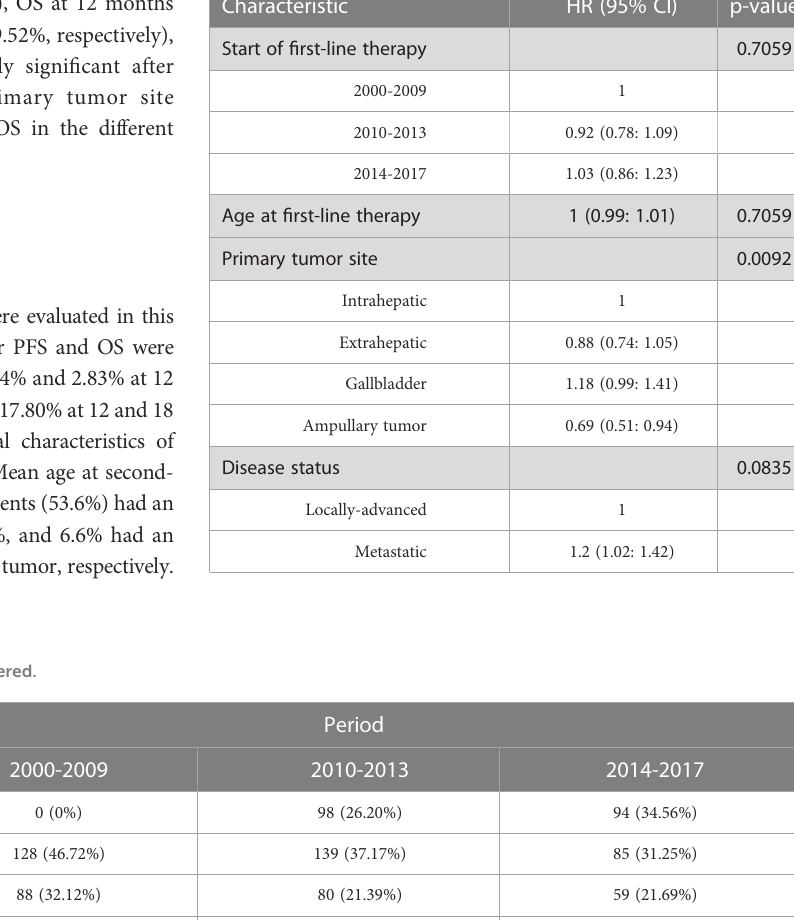
TABLE 3 Cox model after adjusting for confounding factors on PFS for fi rst-line therapy (N=922).